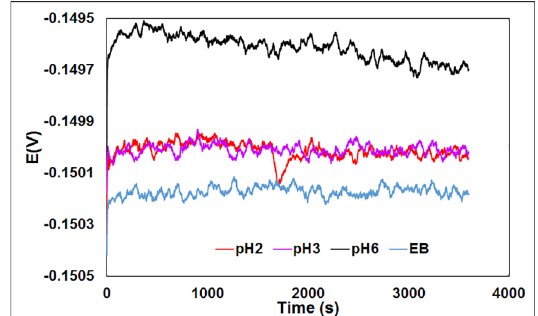
Figure 2. OCP curves of Co-Cr-Mo alloy in NaCl 0.9% solution with different pH (2, 3 and 6) and in mouthwash solution (EB)